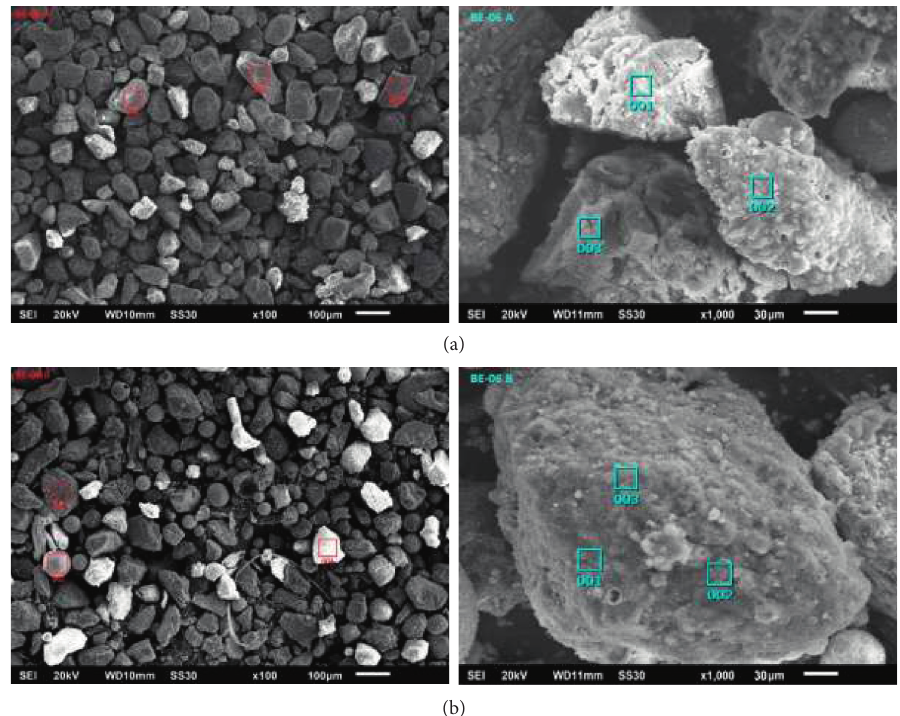
Figure 8: Comparison of 100x and 1,000x magnification of BD-4A at (a) 550 ° C and (b) 600 ° C.